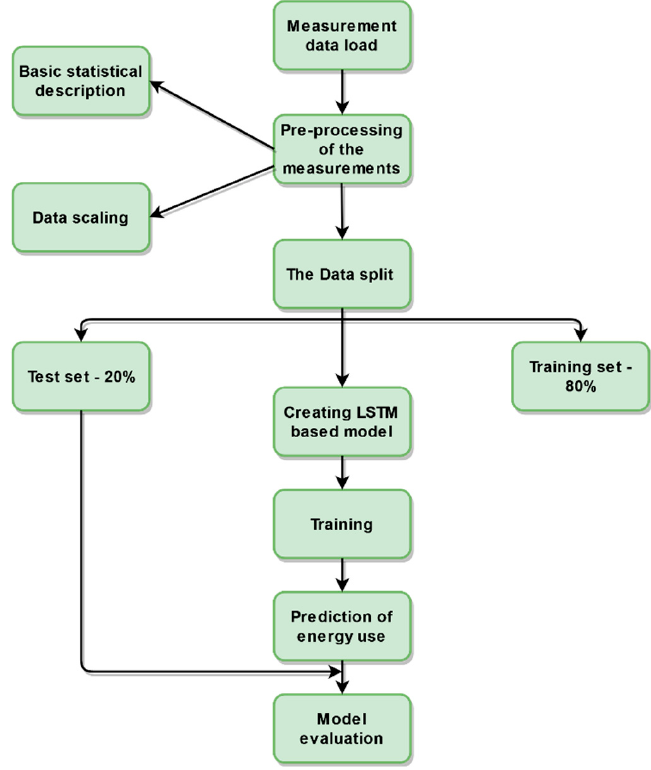
Figure 3. Learning process diagram.